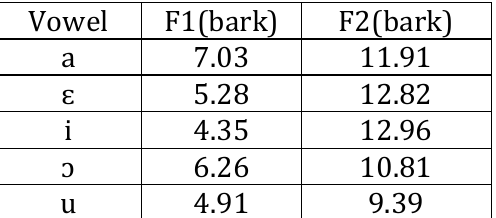
Table 4 : Values in bark for all 5